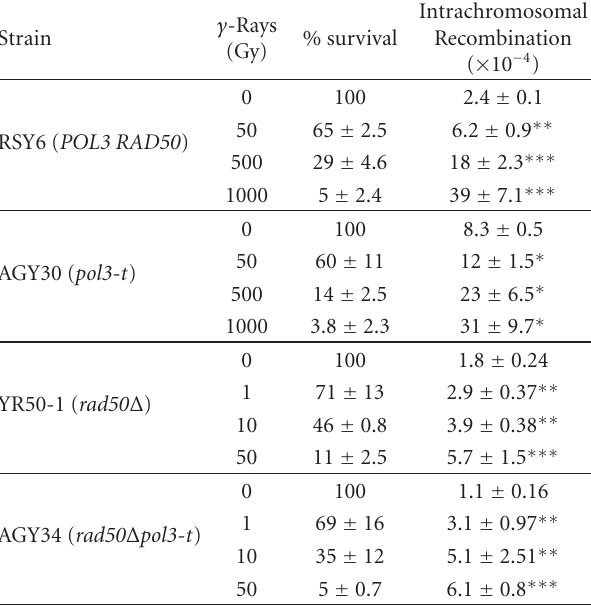
Table 6: E ff ect of pol3-t on γ -ray-induced intrachromosomal recombination in RAD + and rad50 Δ